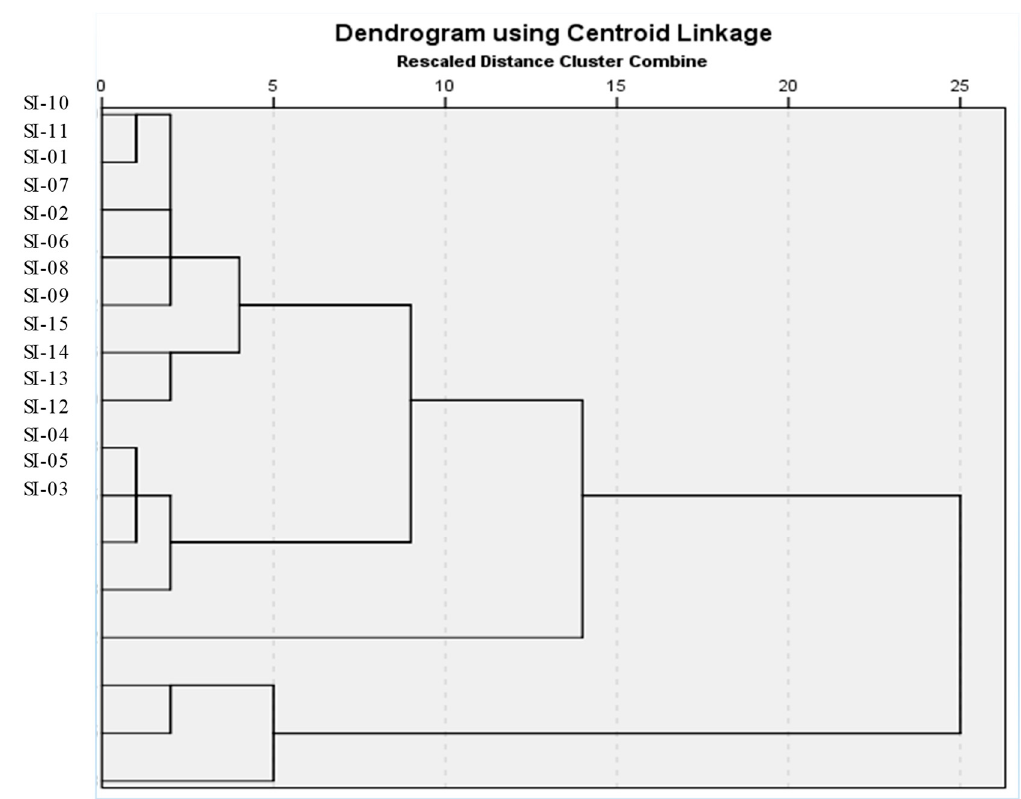
Figure 3. Dendrogram of morphological traits using unweighted pair group method with arithmetic mean clustering (UPGMA) clustering procedures in 15 S. italica accessions grown in the